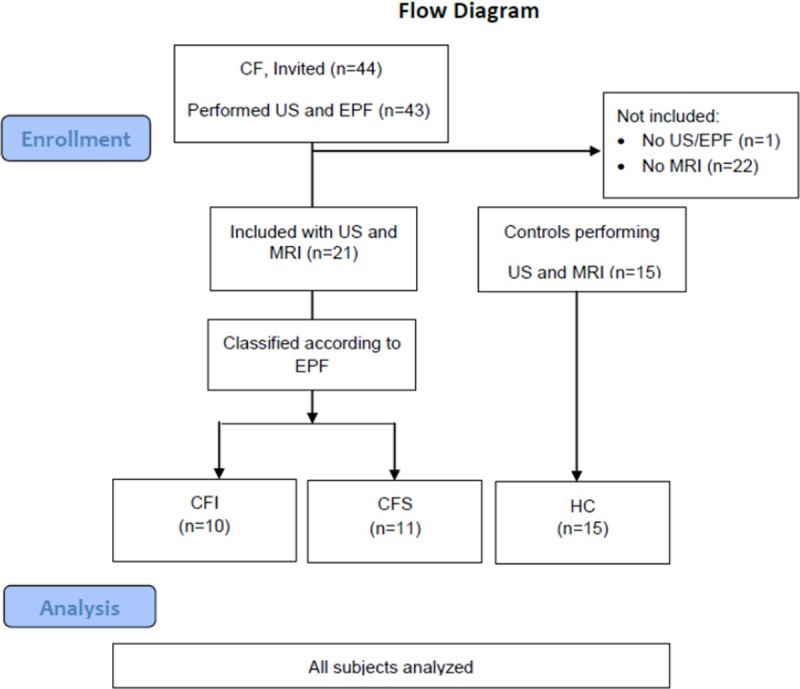
Inclusion flow chart according to the CONSORT guideline.CFI: Pancreas insufficient cystic fibrosis patients. CFS: Pancreas insufficient cystic fibrosis patients. HC: Healthy controls.